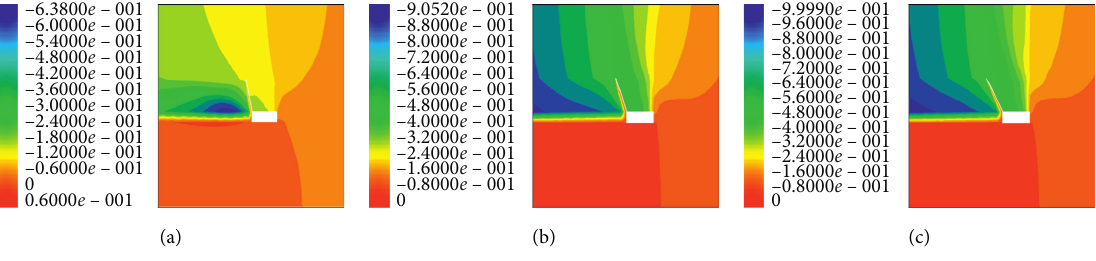
Figure 12: Vertical displacement diagram of different roof cutting angle. (a) 10 ° . (b) 20 ° . (c) 25 °